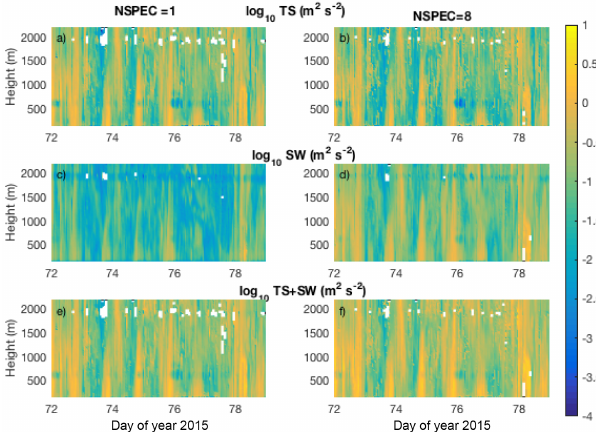
Figure 11. Same as Fig. 5 but for the 915MHz WPR, with NSPEC = 1 on the left column and NSPEC = 35 on the right. Data from all six overlapping heights and all available days are included.